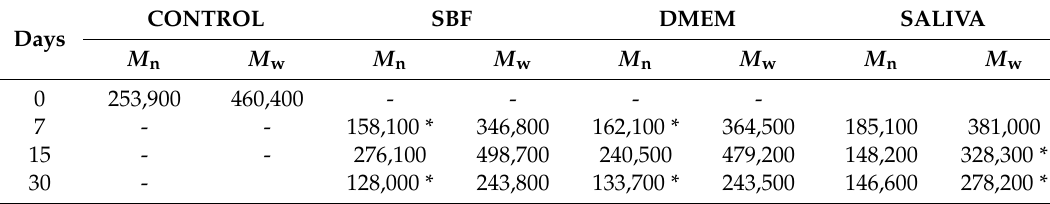
Table 1. Number ( M n ) and weight ( M w ) average molecular weight ( M w ) for non-irradiated PLGA nonwovens obtained in di ff erent in vitro degradation times.